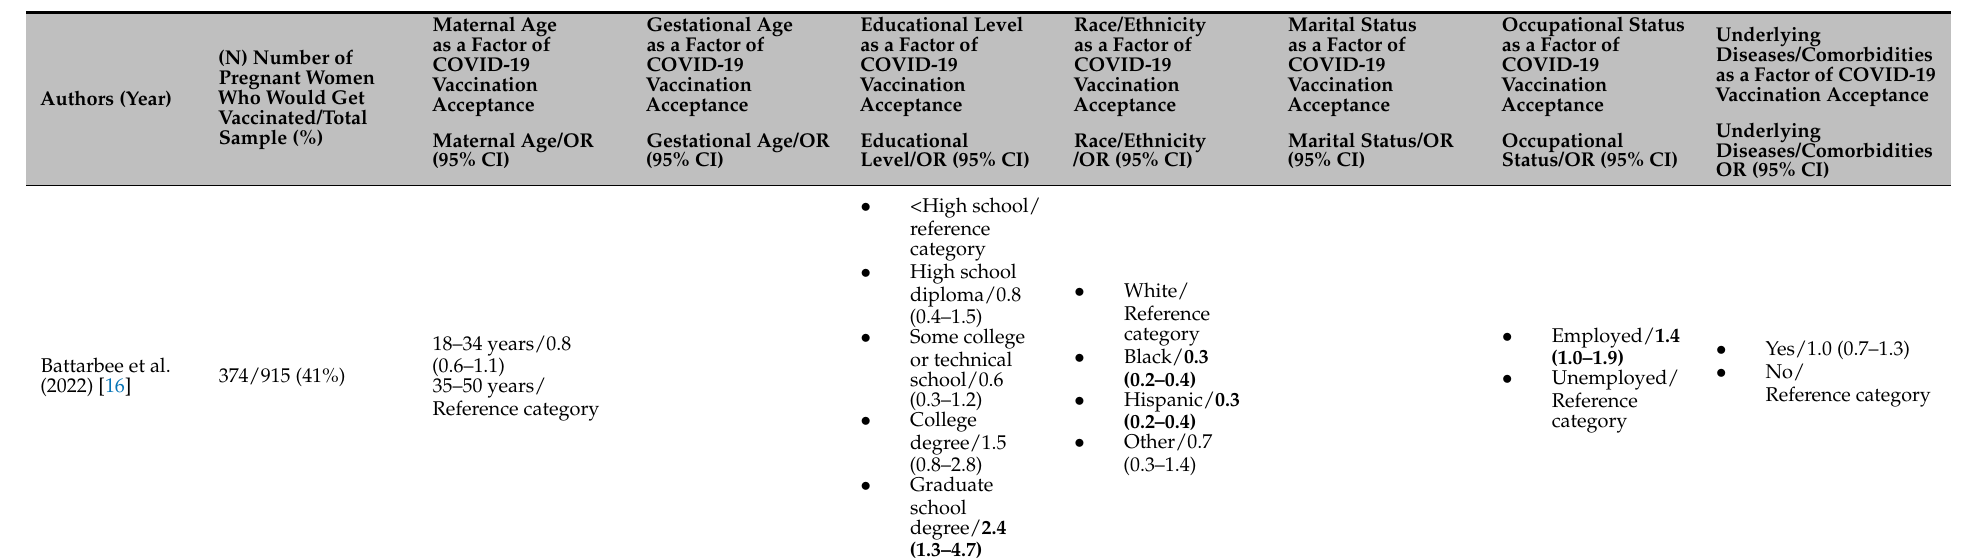
Table 2. Acceptance rate of vaccination against COVID-19 among pregnant women and related factors of